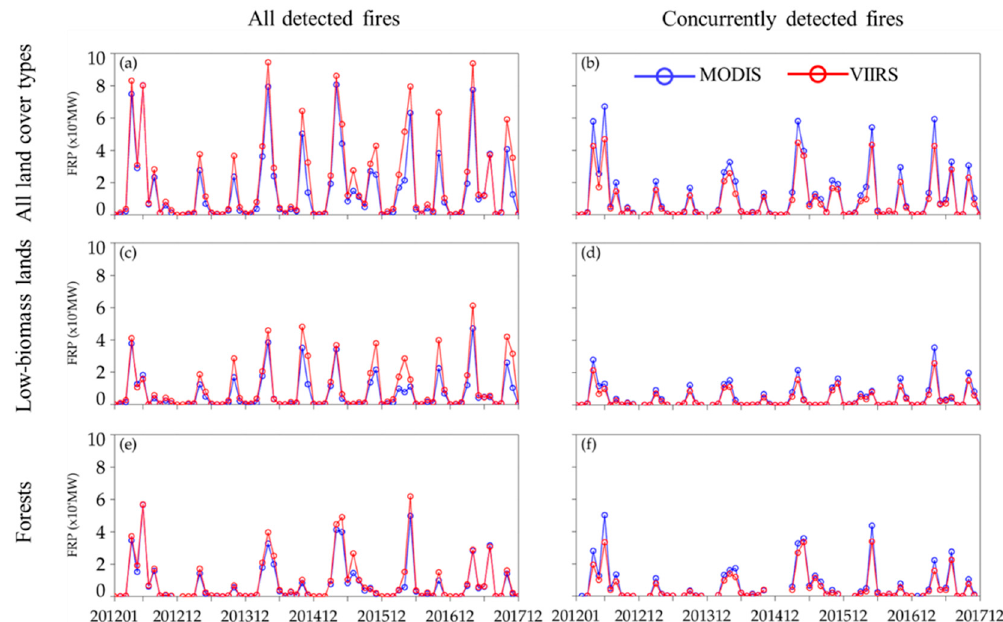
Figure 9. Monthly time series of the total FRP of MODIS (blue curves) and VIIRS (red curves). The left panel shows the total FRP from all detected fires in fire product; the right panel shows the total FRP from concurrently detected fires. ( a, b ) all land cover types; ( c, d ) low-biomass lands; ( e, f ) forests.